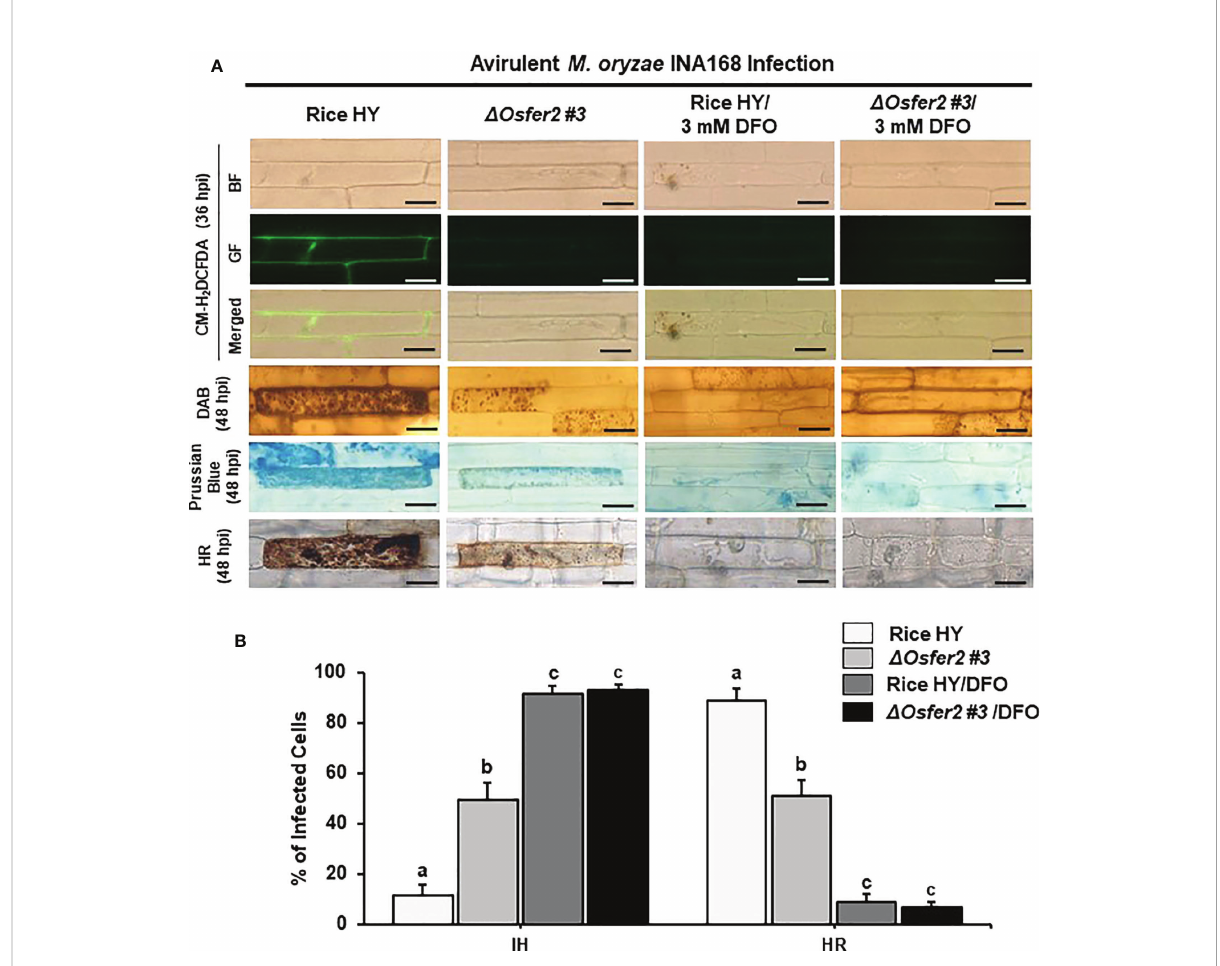
FIGURE 9 Treatment with deferoxamine (DFO) inhibits ROS and ferroptotic HR cell death in leaf sheath epidermal layers of rice HY and D Osfer2 knock-out mutants infected with avirulent Magnaporthe oryzae INA168. Deferoxamine (DFO, 3 mM) was treated onto the epidermal layers at 42 h after inoculation with a conidial suspension (4×10 5 conidia mL -1 ) of M. oryzae INA168. (A) Microscopic images of HR cell death, and DAB, CM-